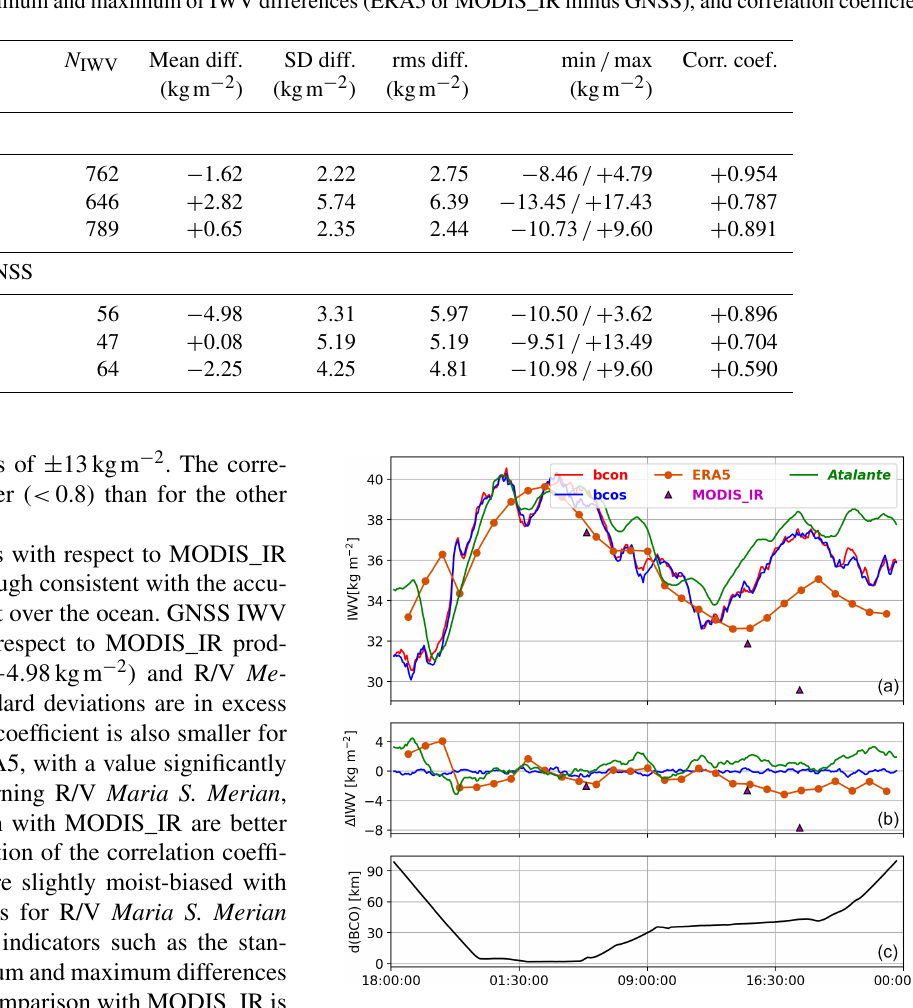
Figure 8. IWV time series from R/V Atalante GNSS data, ground- based GNSS data at the BCO (station BCON and BCOS), ERA5, and MODIS_IR, as Atalante passes close to the BCO between day of year 47 (18:00UTC) and day of year 49 (00:00UTC). (a) The IWV time series; (b) the differences with respect to BCON; and (c) the distance between R/V Atalante and the BCON